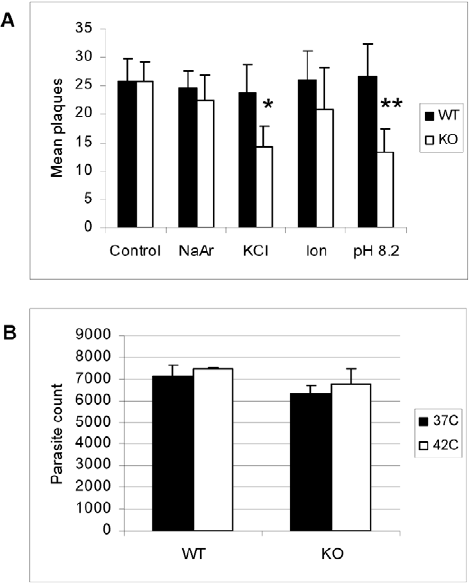
Figure 8. Response of D GCN5-A parasites to other stress conditions. A. Equal numbers of extracellular wild-type (WT) or D GCN5-A (KO) were subjected to one of the following stresses for 30 min before being placed back into HFF culture under normal growth conditions: 0.6 M KCl, 5 m M sodium arsenite (NaAr), or 1 m M ionophore (Ion). Alkaline pH (8.2) stress was used as a positive control and no stress as a negative control. The mean number of plaques after five days recovery in HFF monolayer culture is shown. P values for Student’s t- test are denoted as *=0.03 and **=0.02. B. Equal numbers of extracellular wild-type (WT) or D GCN5-A (KO) were incubated at 37 u C PCR-based B1 assay.